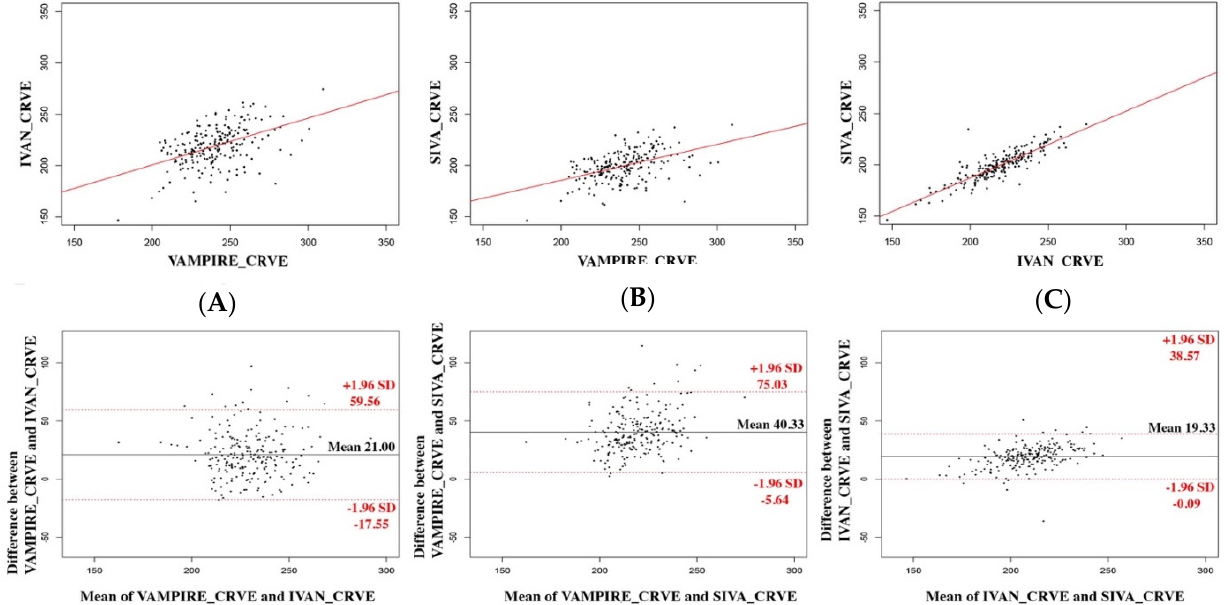
Figure 3. Agreement between each software for CRVE measurements. The three software applications are compared two by two: ( A ) IVAN and VAMPIRE, ( B ) SIVA and VAMPIRE, ( C ) SIVA and IVAN. Scatterplots are represented above with regression lines; Bland–Altman plots are represented below.